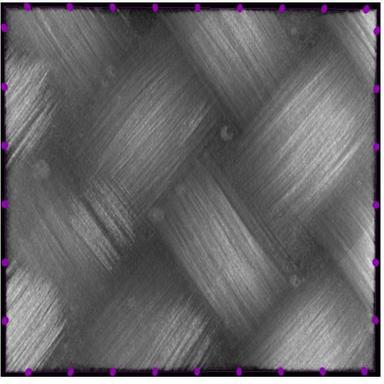
Micro-CT scan of a 5 wt% microcapsule specimen.